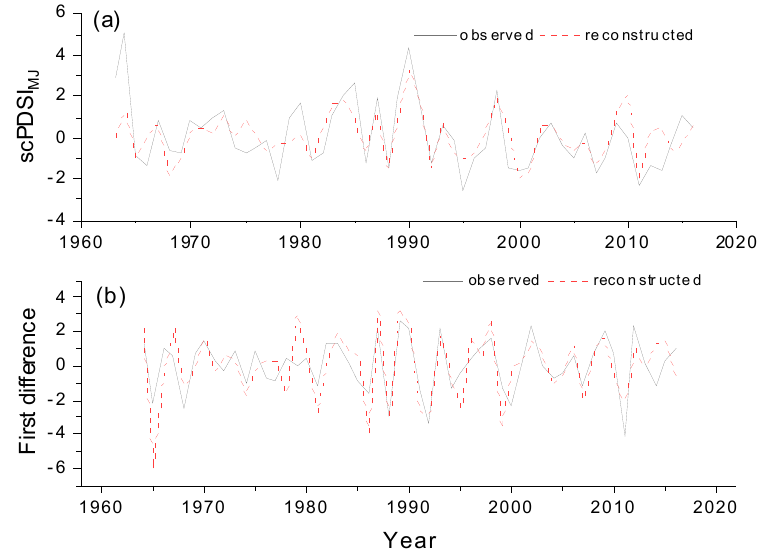
Figure 4. ( a ) Comparison of the observed (solid line) and the reconstructed (dash line) scPDSI MJ during the period 1963 — 2016 CE at Mt. Shiren. ( b ) Comparison of the first-order difference sequence of the observed (solid line) and reconstructed (dash line) scPDSI MJ . Table 2. Calibration and verification statistics for reconstructed scPDSI MJ.